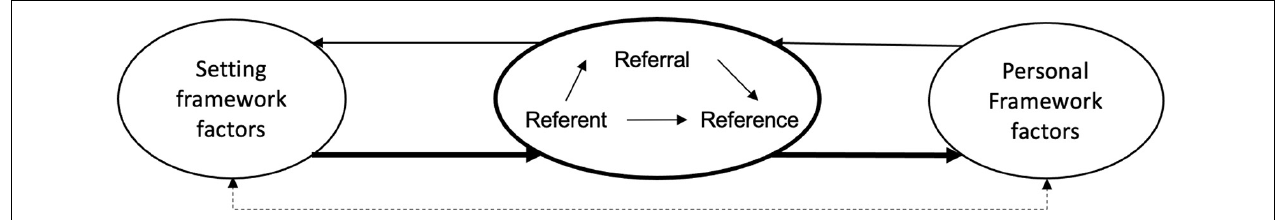
FIGURE 2 | Attributions and their framework